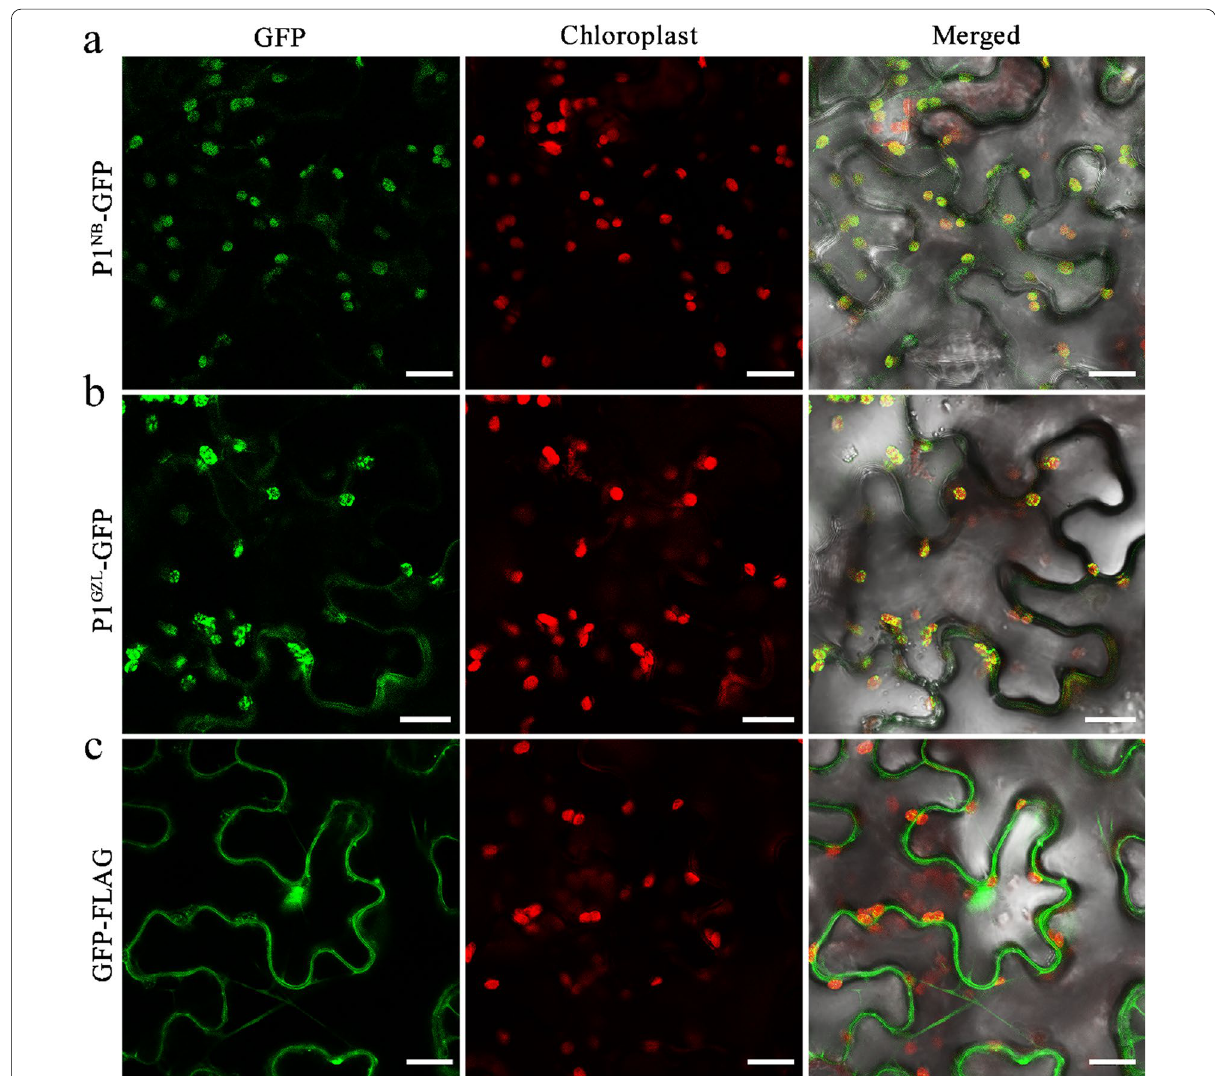
Fig. 6 Subcellular localization of P1 NB -GFP and P1 GZL -GFP in N. benthamiana . Confocal images of N. benthamiana cells showing the subcellular localization patterns of a P1 NB -GFP, b P1 GZL -GFP and c GFP-FLAG. Images were taken at 48 h post-infiltration. Scale bars: 20 μm